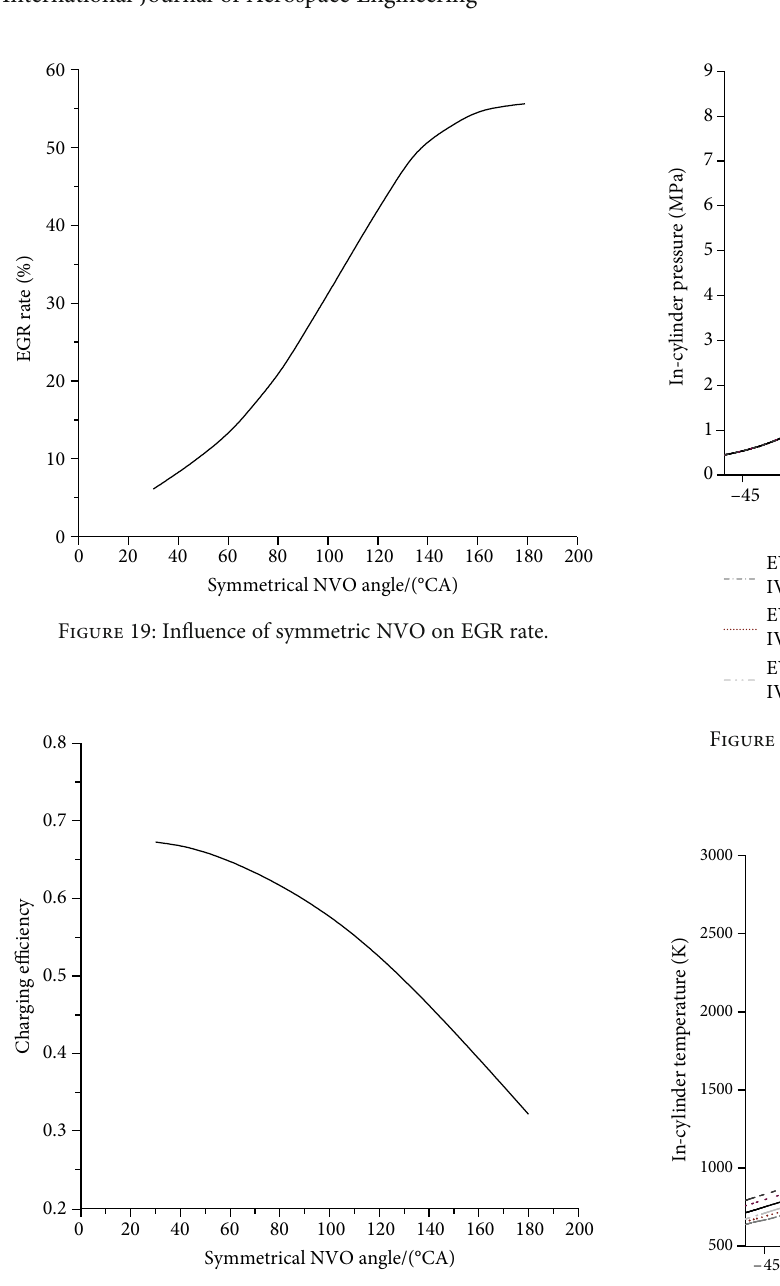
Figure 20: In fl uence of symmetric NVO on charging e ffi ciency.